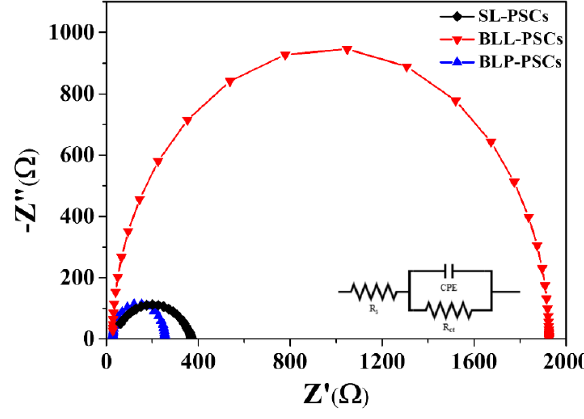
Figure 5. Nyquist plots of SL-PSCs, BLL-PSCs, and BLP-PSCs.